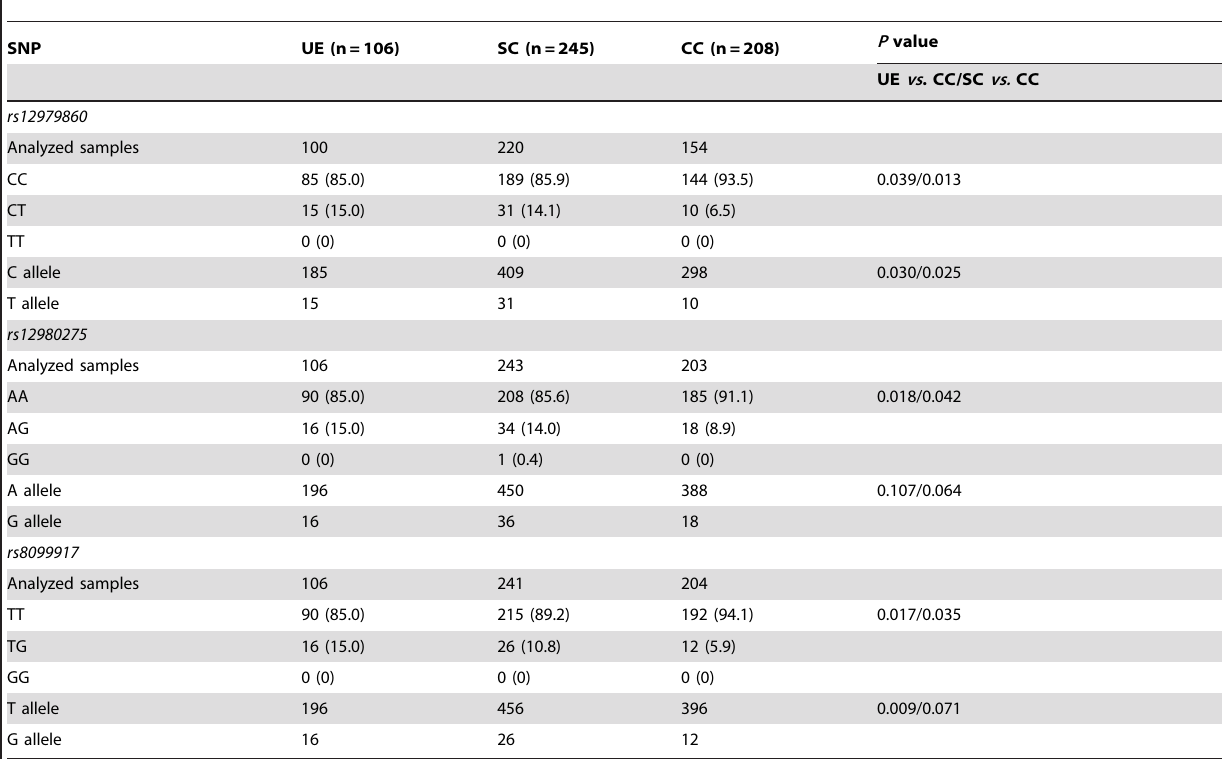
Table 2. Prevalence of three SNPs ( rs12979860 , rs12980275 , and rs8099917 ) in UE, SC, and CC